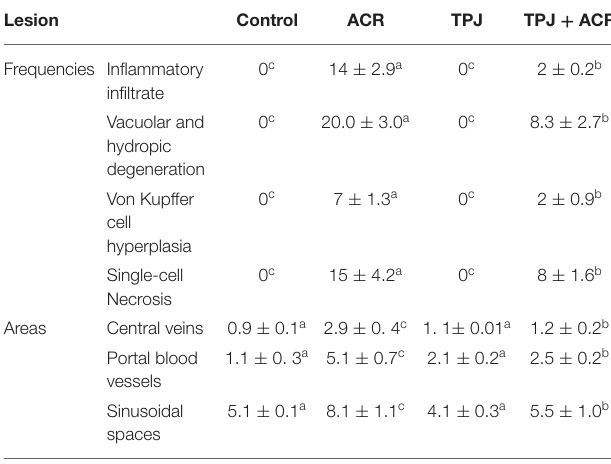
TABLE 5 | Ameliorative impacts of TPJ against morphometric analysis and score lesions induced by acrylamide rat’s